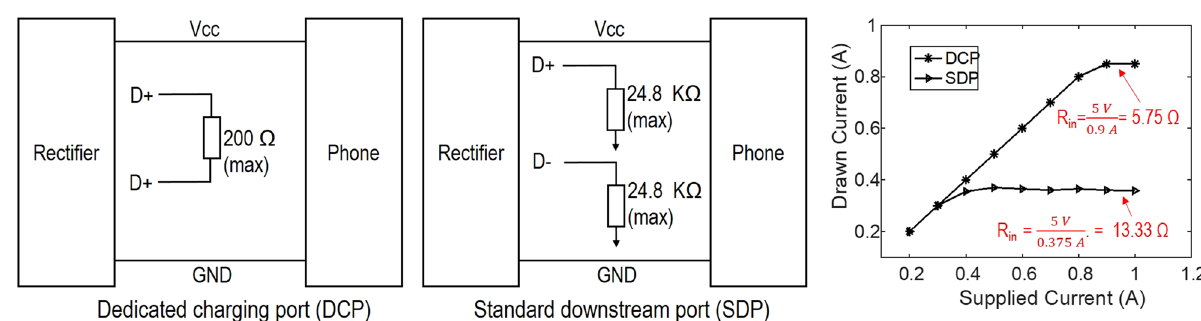
Figure 6. Standard charging modalities of a USB 2.0 interface, namely DCP and SDP, and comparison of measured input resistance. Plot generated using Matlab R2019b available at https:// mathw orks. com. The figure was drawn using MS-PowerPoint